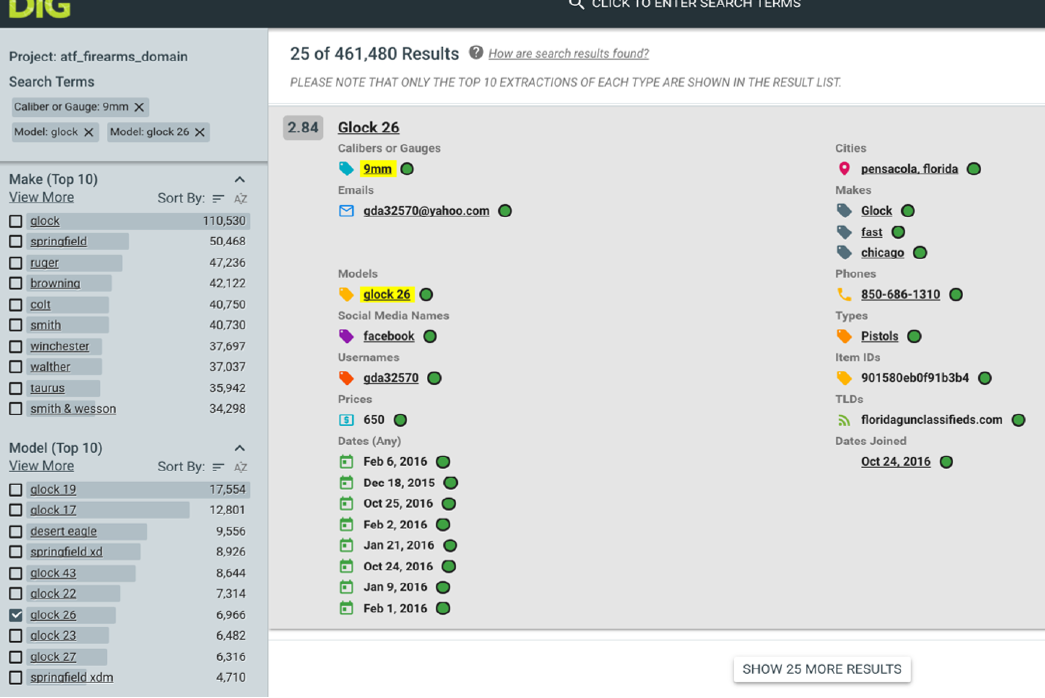
Figure 5. The search interface offered by myDIG ( illegal firearms sales domain).